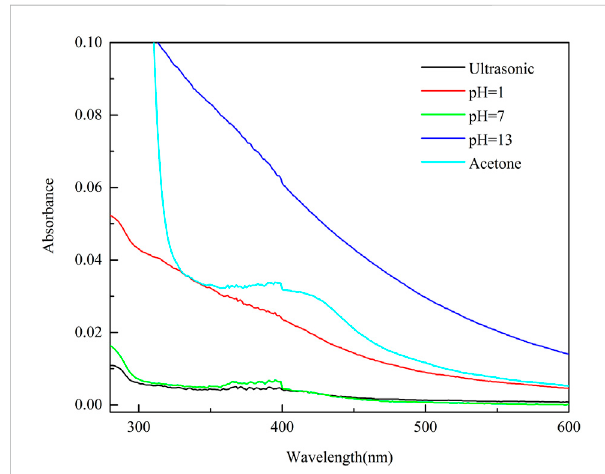
FIGURE 9 UV-Vis spectra of eluates from PVDF/DA membranes in different environments.